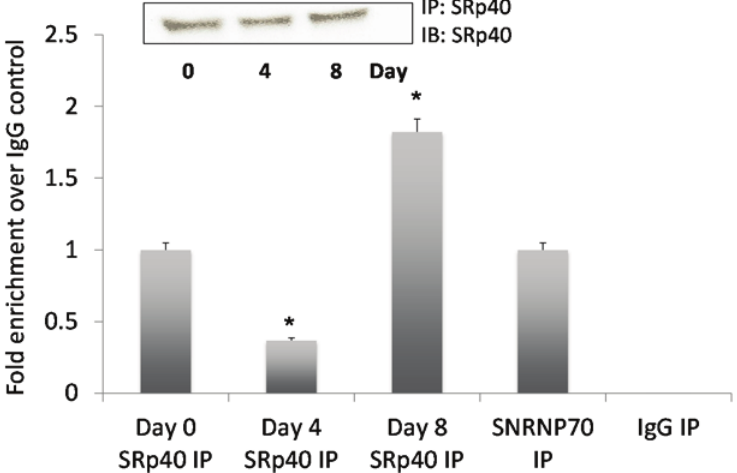
Figure 4. NEAT1 associated with SRp40 protein on days 0, 4, and 8 of adipogenesis. Cell lysates were immunoprecipitated with SRp40 antibody using the RIP assay kit from Sigma. SNRNP70, positive, and negative IgG controls were run on days 0, 4, and 8. Quantitative RT-PCR analysis of NEAT1 is expressed as fold enrichment over the IgG control. The blot of SRp40 IP is shown as an inset. This experiment was repeated three times with similar results.